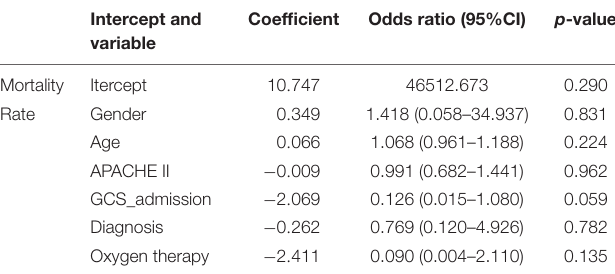
TABLE 3 | Logistics regression analysis of mechanical ventilation.